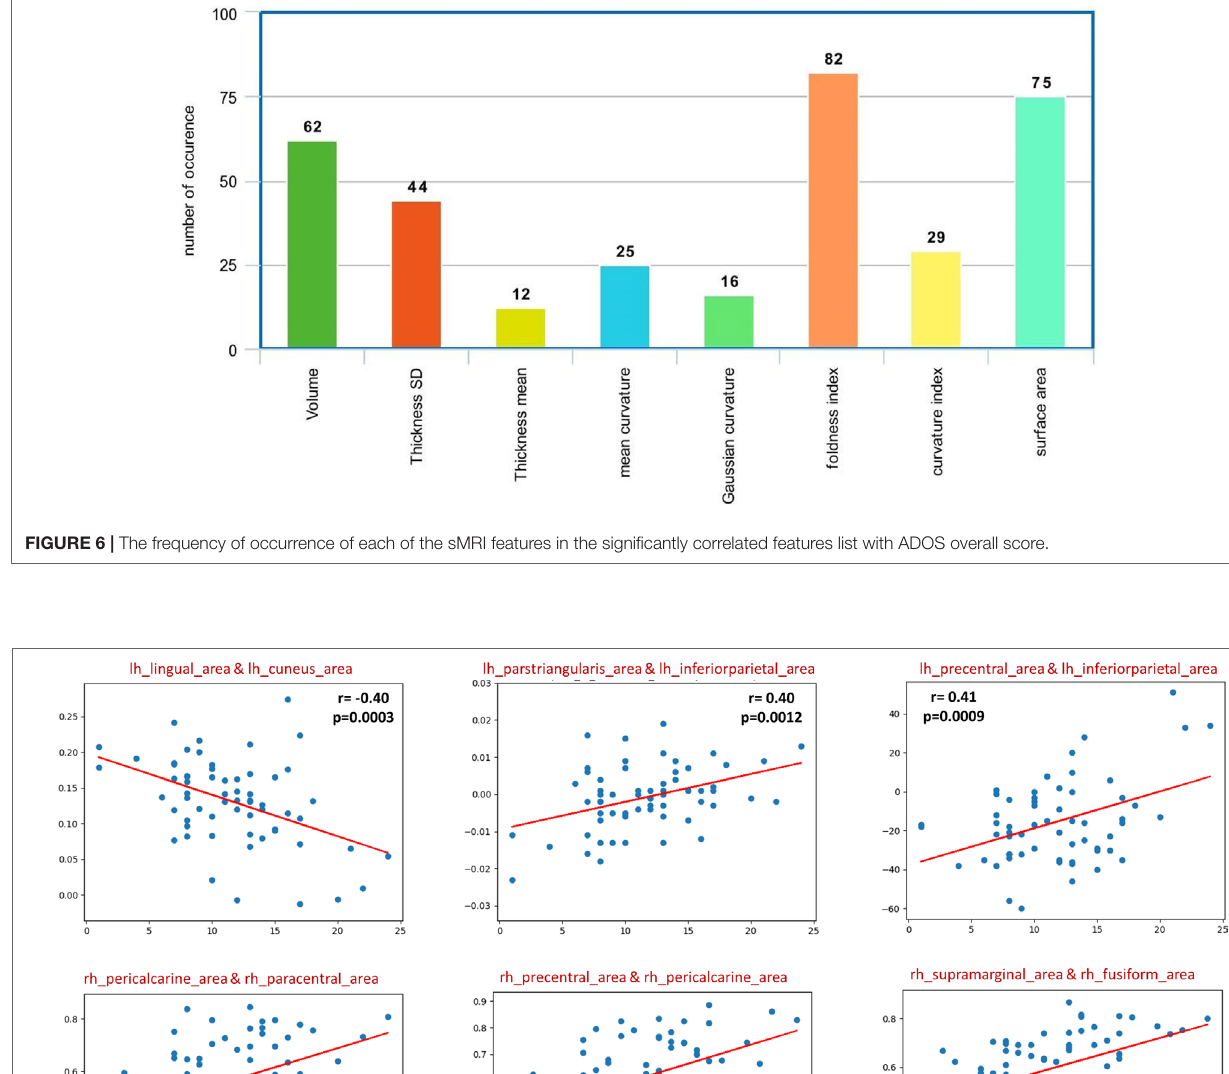
Local and Global Diagnosis For each subject, the local probabilities for both sMRI and fMRI feature matrices are calculated. These probabilities are used to generate the personalized brain maps. The output of the local classification is two matrices P and P with the same S F size as the feature matrices F and S .